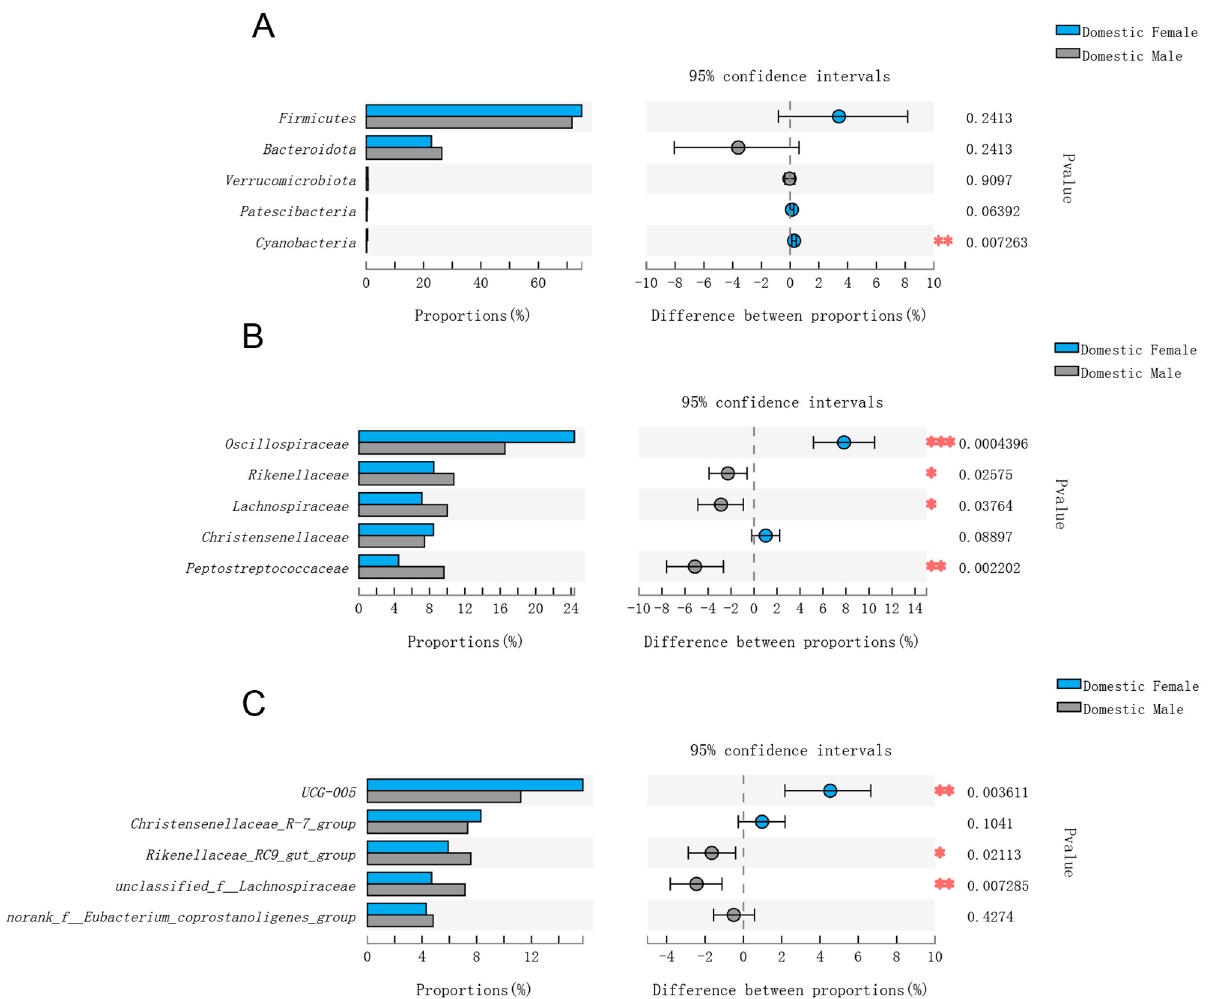
Figure 2. Comparison of gut microbial diversity between domestic females and males of Datong yaks. ( A ) Top five phyla; ( B ) top five families; ( C ) top five genera. Significant differences in the gut microbiota between domestic females and wild males of Datong yaks are indicated by p values and asterisks (* if 0.01 < p < 0.05, ** if 0.001 < p < 0.01, and *** if p < 0.001).